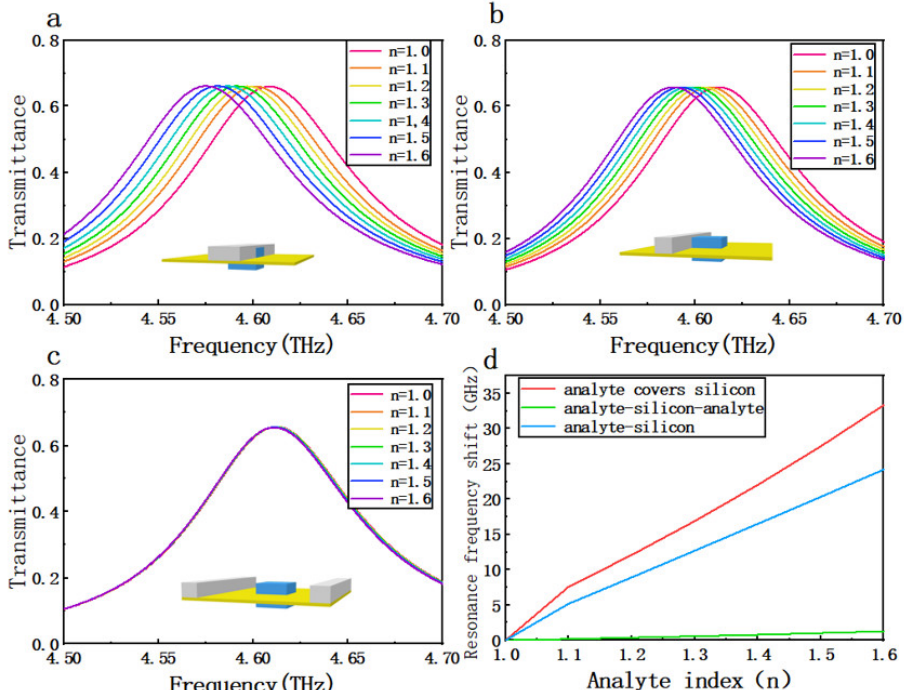
Figure 3. ( a ) Transmittance spectra of analyte covered with a silicon particle. ( b ) Transmittance spectra of the analyte when placed beside a silicon particle. ( c ) Transmittance spectra of the analyte when placed on either side of the silicon particle. ( d ) Comparison of transmittance for the three arrangements.